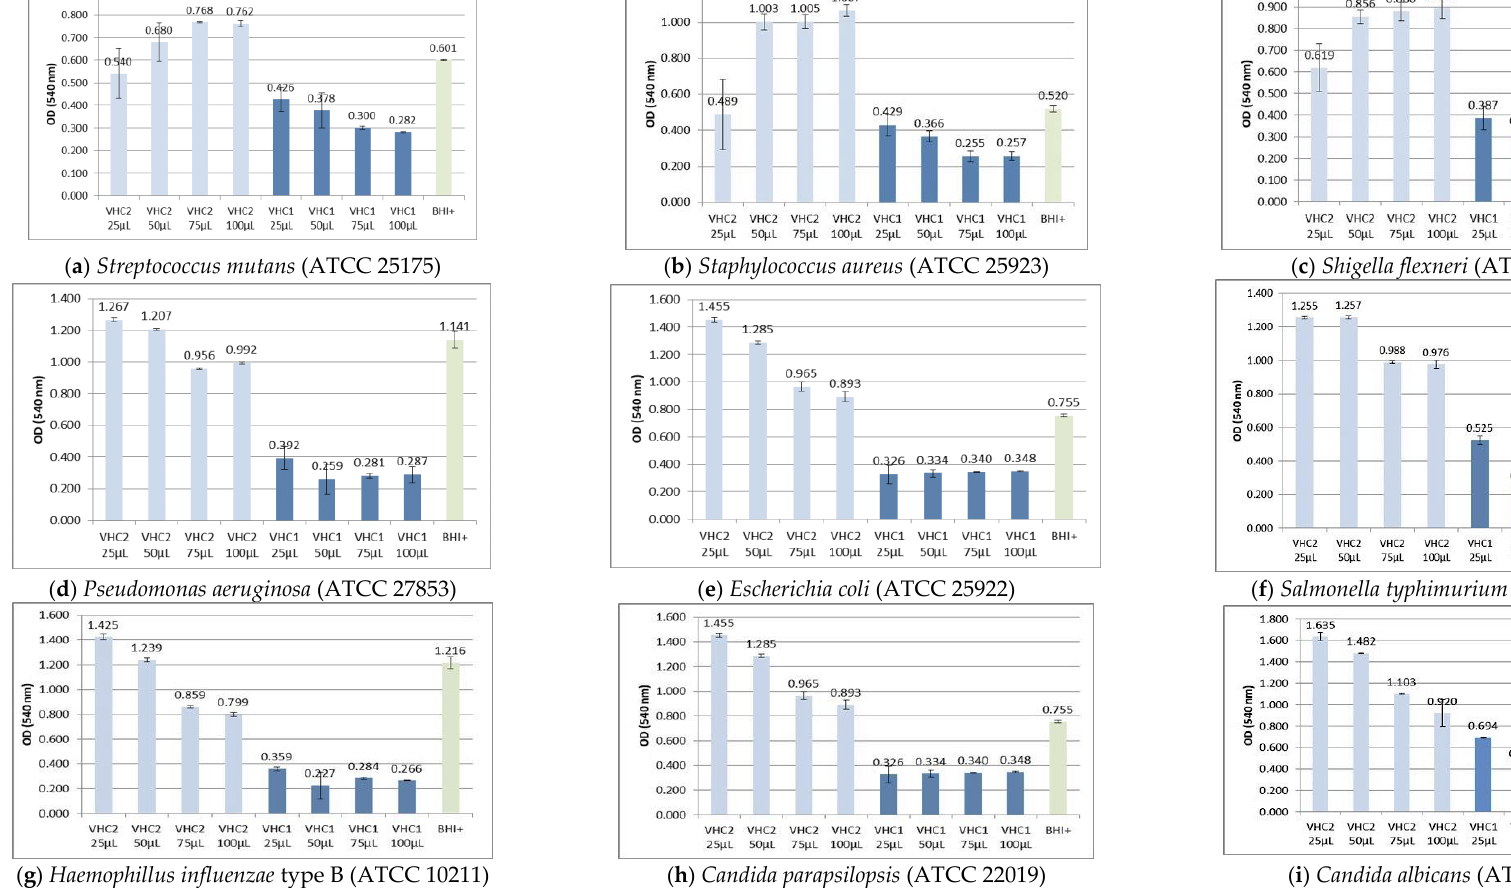
Figure 2. Antimicrobial activity expressed as OD (mean ± SD) values obtained according the formula (1). BHI+: simple strains suspensions in brain heart infusion broth used as a positive control.